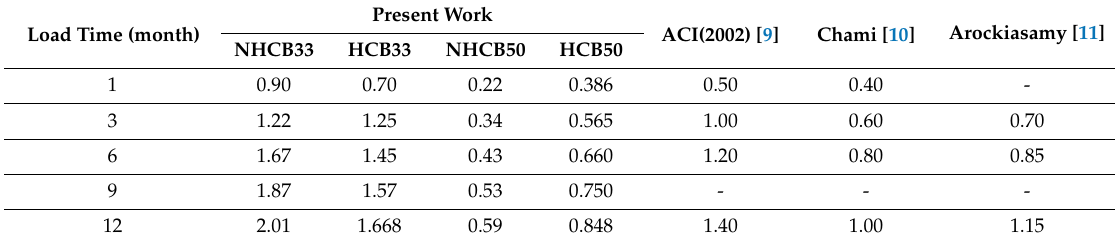
Table 3. Obtained time-dependent factors with other investigations